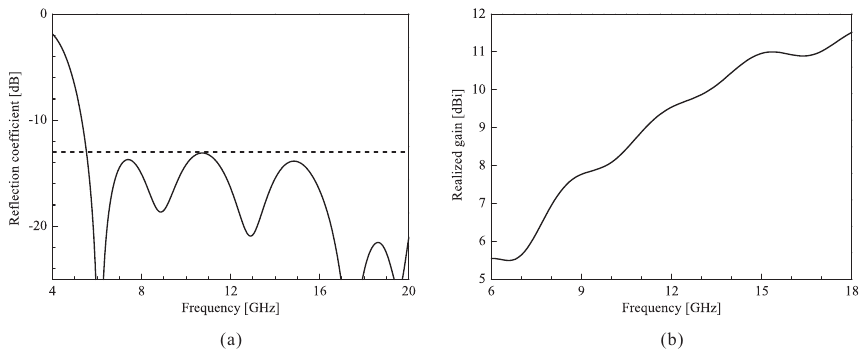
Figure 7. Simulated results of the TEM horn antenna: ( a ) reflection coefficient and ( b ) realized